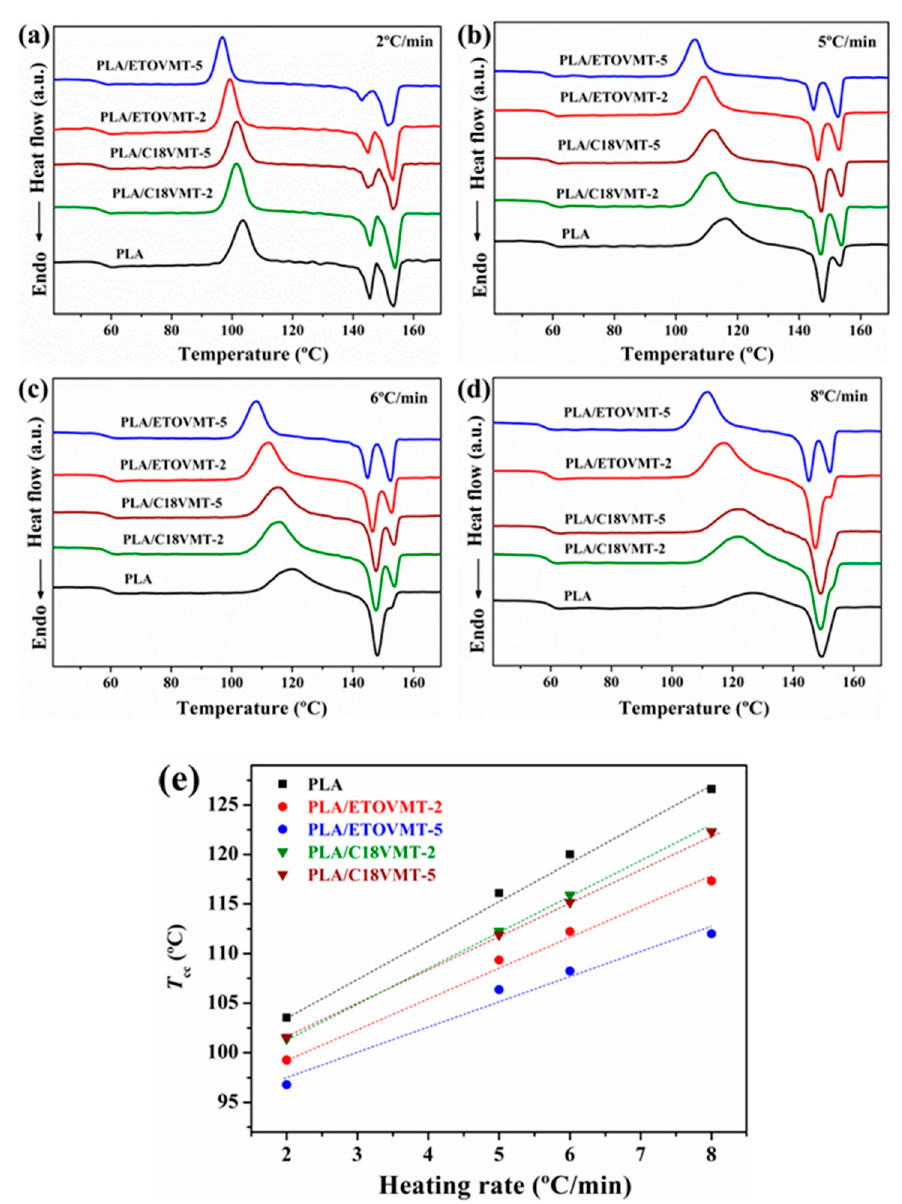
Figure 3. DSC thermograms of neat polylactide (PLA) and PLA/VMT nanocomposites obtained at heating rates ( a ) 2 °C/min, ( b ) 5 °C/min, ( c ) 6 °C/min, and ( d ) 8 °C/min. ( e ) Cold crystallization temperature as a function of the heating rate for PLA and PLA/VMTs.